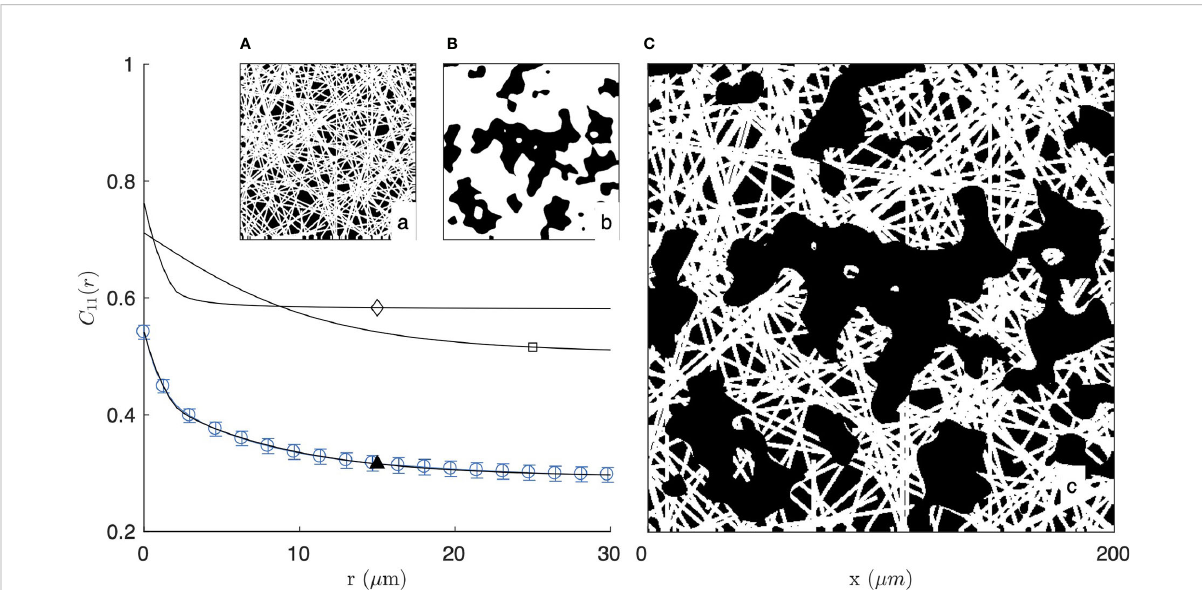
FIGURE 4 Covariance of the fi bre-aggregate model, with homogeneous fi bre model at small scale ( A and ⋄ ) and clipped Gaussian- fi eld model for the large-scale aggregates ( B and □ ), combined to yield a two-scale structure ( C and ▲ ). The calculated covariance is compared with that of the 2 mg/mL gel imaged by fl uorescence microscopy (same as Figure